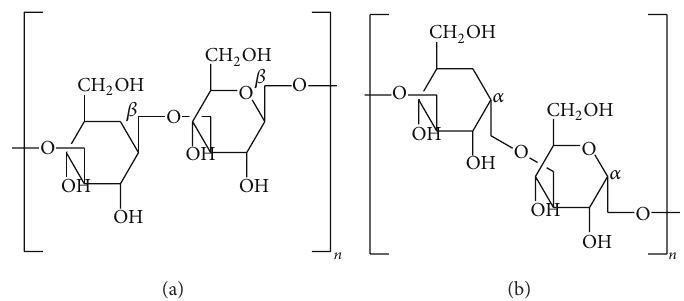
Figure 1: Molecular structure of 𝛽 -(1 → 3)-D-glucans (a) and 𝛼 -(1 → 3)-D-glucans